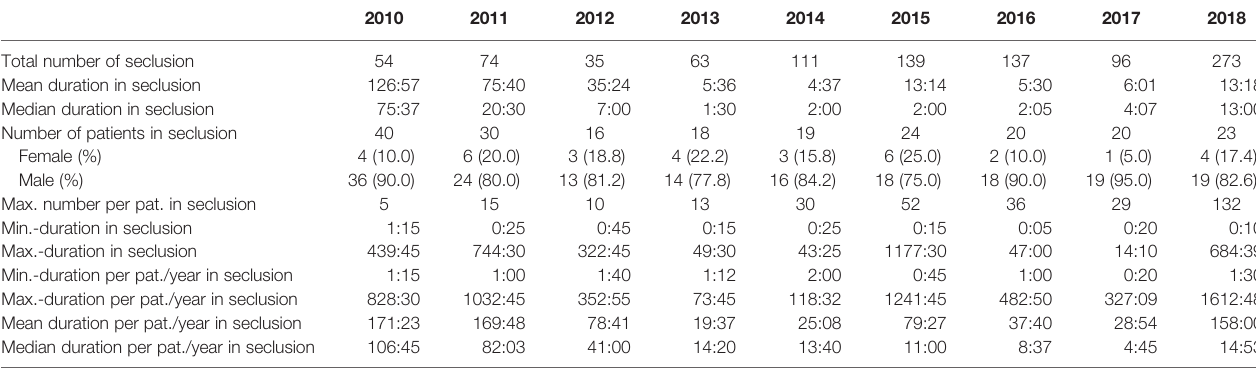
Durations are reported in the format